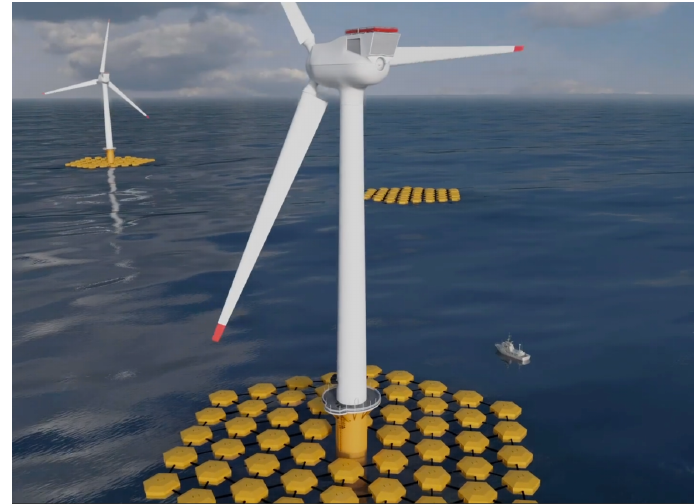
Figure 1. Artist’s sketch of a system of floater blanket wave energy converters (WECs) connected to offshore wind turbines. Source: